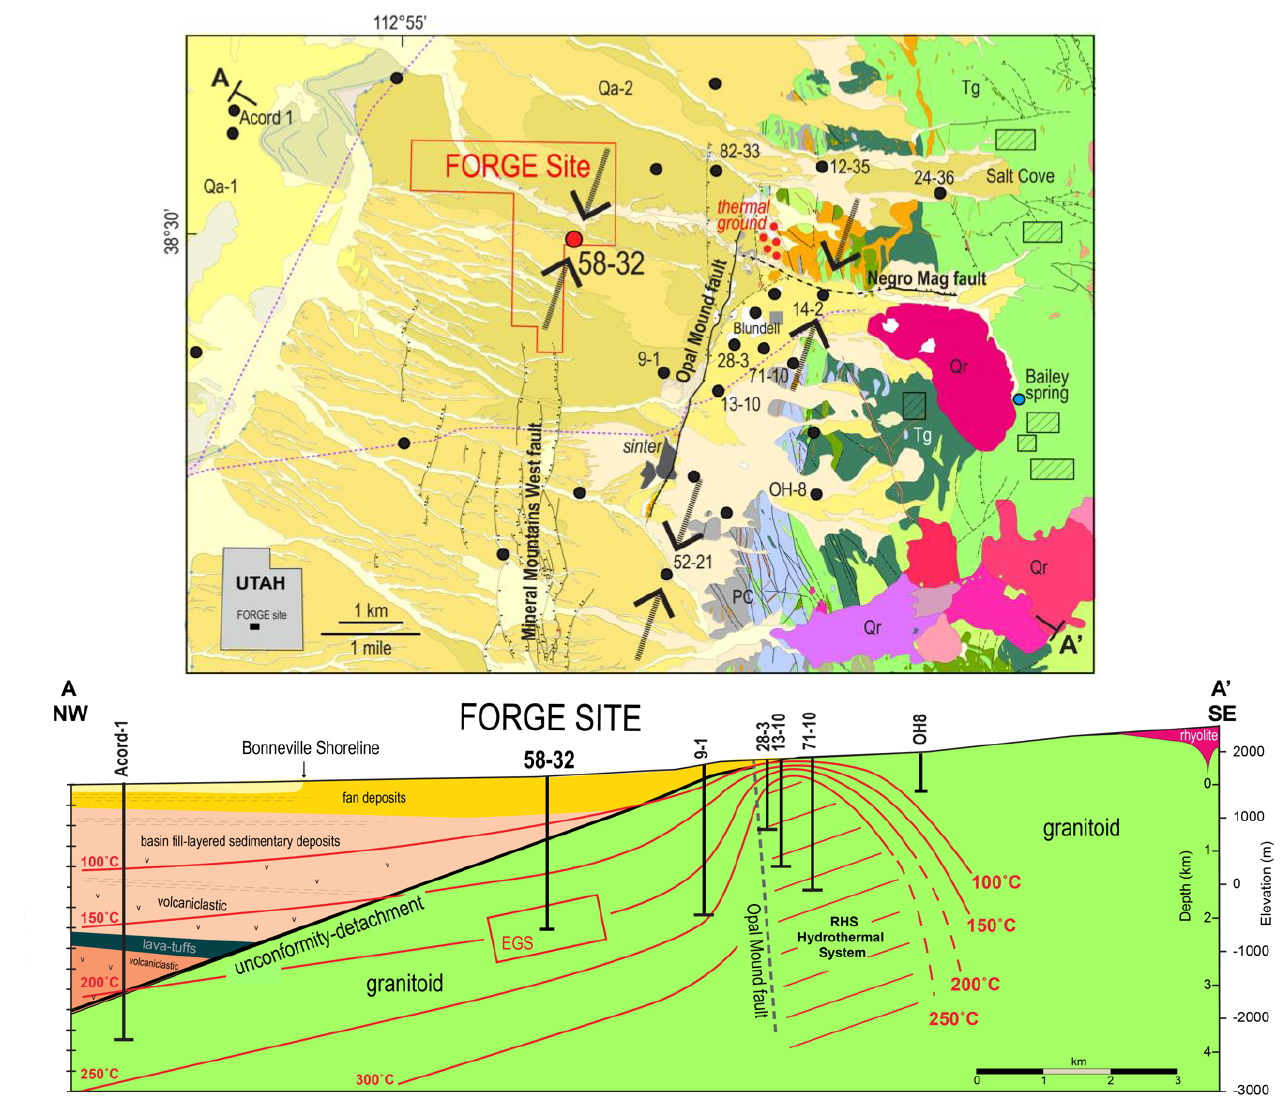
Figure 3. Upper : Geological map of the Utah FORGE site area; Lower : Cross section of the Utah FORGE site area. Maximum horizontal stress is highlighted with the black arrows. Beige (Qa-1): silts and sands of Lake Bonneville; Yellow (Qa-2) fan deposits; Purple (Qr): Quaternary rhyolite lava; Dark teal and spring green (Tg): Tertiary granitoid; Grey (PC): Precambrian gneiss; wells are highlighted as black circles; only the reference 58-32 well is a red circle. Red rectangle in the cross section represents an approximate location of the planned enhanced geothermal system and the thermal profiles are represented by red lines